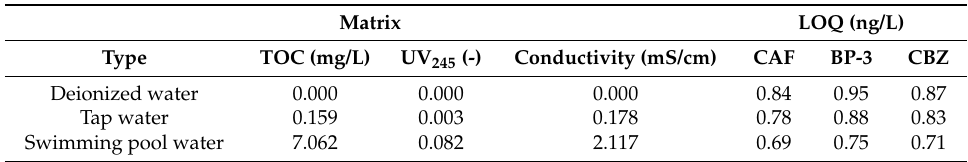
Table 7. Limits of Quantification obtained in the most optimal solid phase extraction methodology (methanol + acetonitrile and ENVI-18) and the measurements of organic and inorganic substance presence for different matrices.